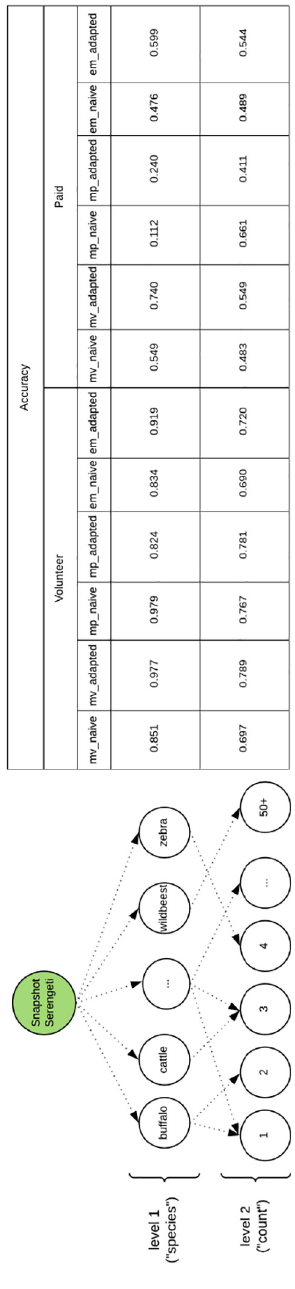
Figure 8. Accuracy by